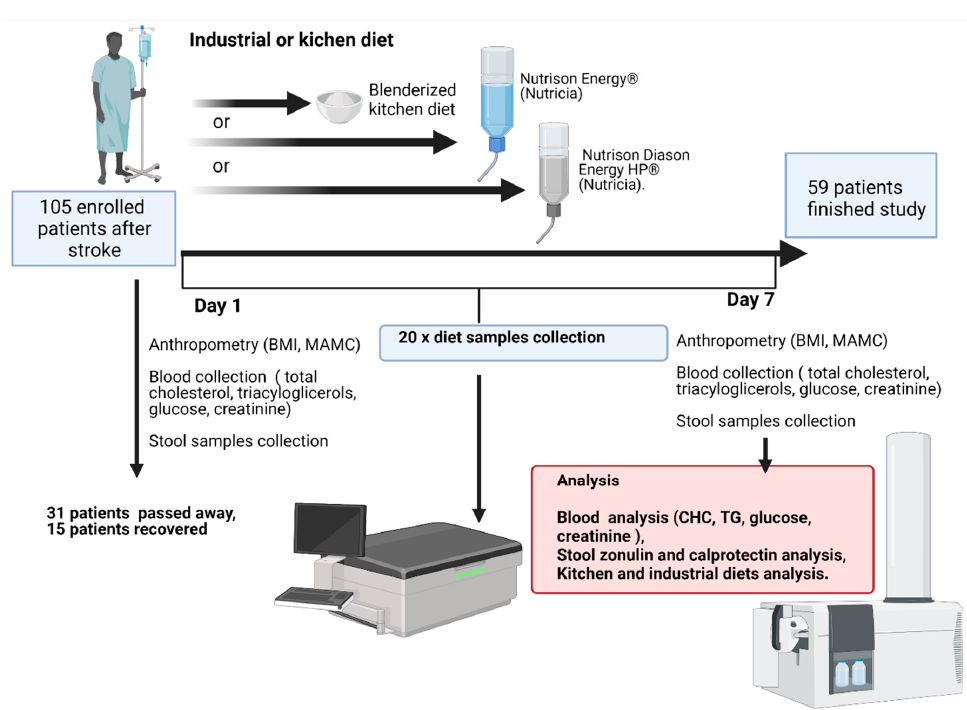
Figure 1. Study diagram. BMI—Body Mass Index, MAMC—mid-arm muscle circumference, CHC—cholesterol level, TG—triglycerides level Nutritional status was evaluated through anthropometric measurements: height, calf and arm circumference (anthropometric tape measure), and subscapular skinfold thickness (Saehan metal skinfold calliper—Baseline, South Korea). As all patients were in a lying position, their parameters were estimated based on other measurements. Stature was predicted relative to the distance from the top to bottom of medial tibia, using the knee height equation by Chumlea et al. [11] for Caucasian populations [11]. In turn, body weight was predicted by measuring calf and arm circumferences, knee length, and subscapular skinfold thickness (according to the equation by Chumlea et al.) [12]. The basal metabolic rate and body composition were assessed by bioelectric impedance using a BIA Akern device (Cosmed, Italy).